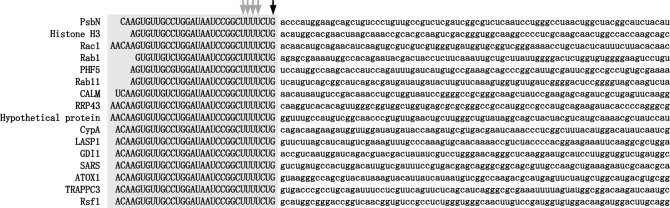
Alignment of the spliced leader trans-spliced mRNAs of P. micropora.cDNAs contain 28–33 base common sequences at their 5′ ends. These contigs were annotated using COG and NCBI-nr database (PsbN; photosystem II PsbN, Histone H3, Rac1; Ras-related protein Rac1, Rab1; GTP-binding protein, PHF5; PHF5-domain-containing protein, Rab11; GTPase Rab11/YPT3, CALM; Calmodulin, RRP43; Exosome complex exonuclease RRP43, CypA; Cyclophilin, LASP1; LIM and SH3 domain protein, GDI1; Rab GDP dissociation inhibitor alpha, SARS; seryl-tRNA synthetase, ATOX1; copper transport protein ATOX1, TRAPPC3; trafficking protein particle complex subunit 3, Rsf1; RNA-binding protein Rsf1). The common sequence is shaded, with the UUU triplet and 3′ terminal G indicated by the gray and black arrows, respectively.